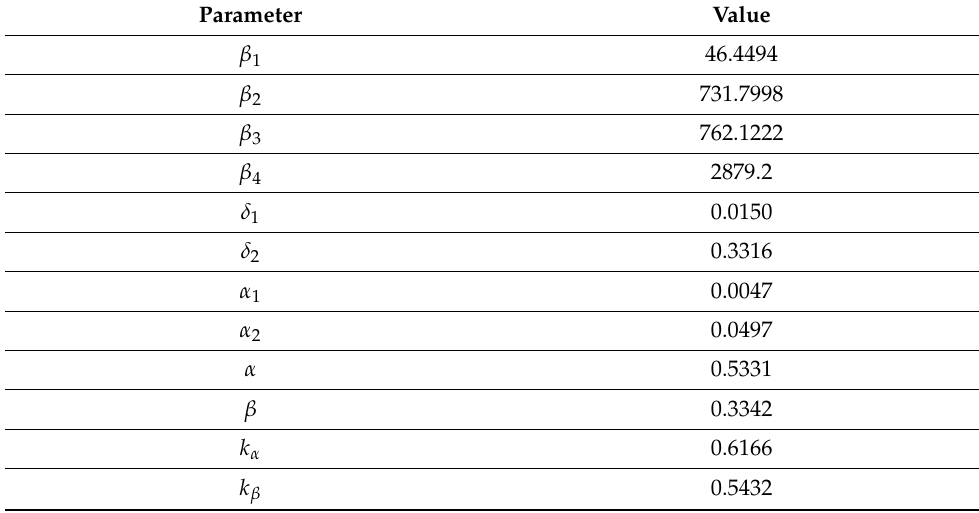
Table 2. Sample values of the ADRC units. Figure 3. The control signals with curve indices from 1 to 9 represent LESO, NLESO types I, II, III,